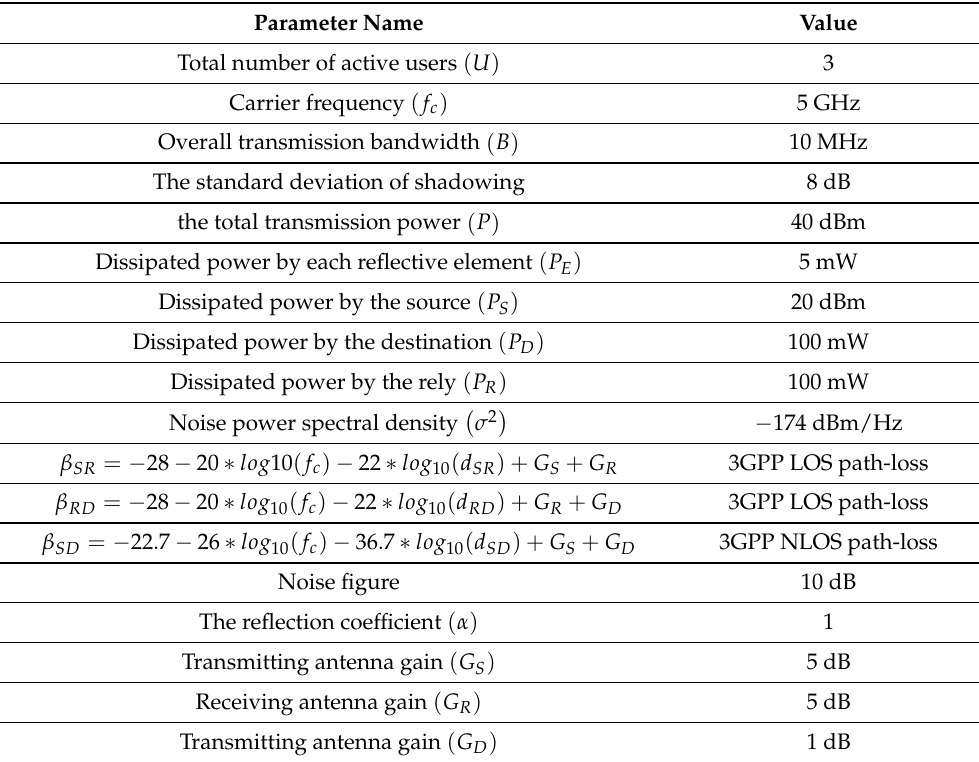
Table 1. Simulation